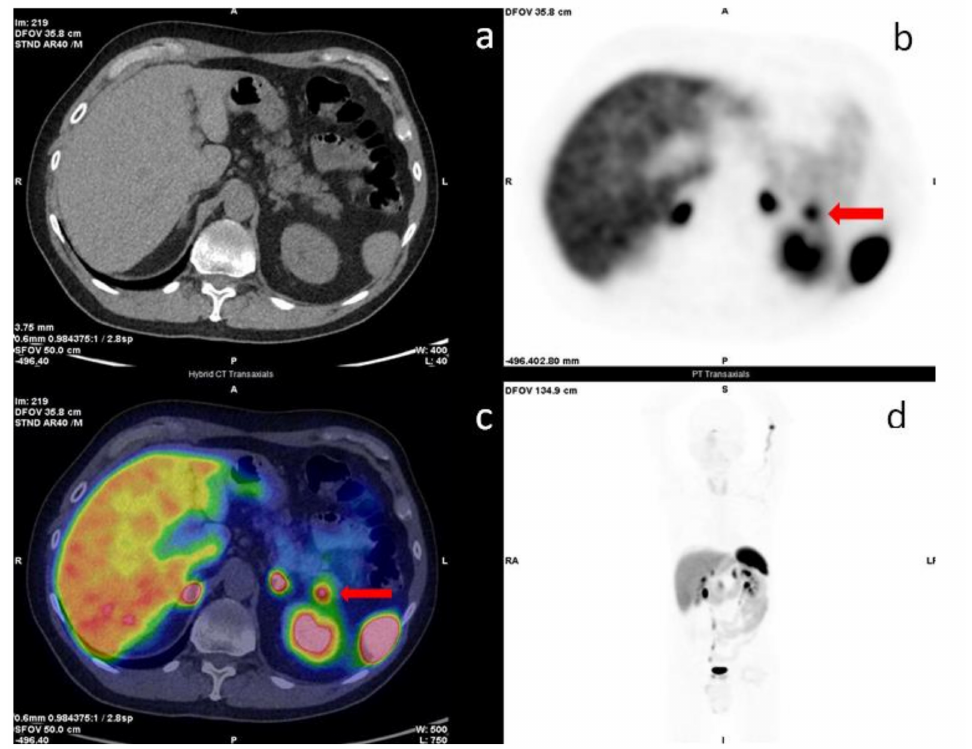
Figure 2. 68 Ga-DOTA-TOC PET/CT transaxial images. Low-dose CT: ( a ), PET: ( b ), image-fused PET/CT: ( c ), and maximum intensity projection (MIP) ( d ). The red arrows in images ( b , c ) show a focal uptake in the pancreatic tail while restaging patient for small bowel NET (G2, Ki67 3%). The mor- phological imaging was not decisive for the diagnosis. Cytology revealed accessory intrapancreatic